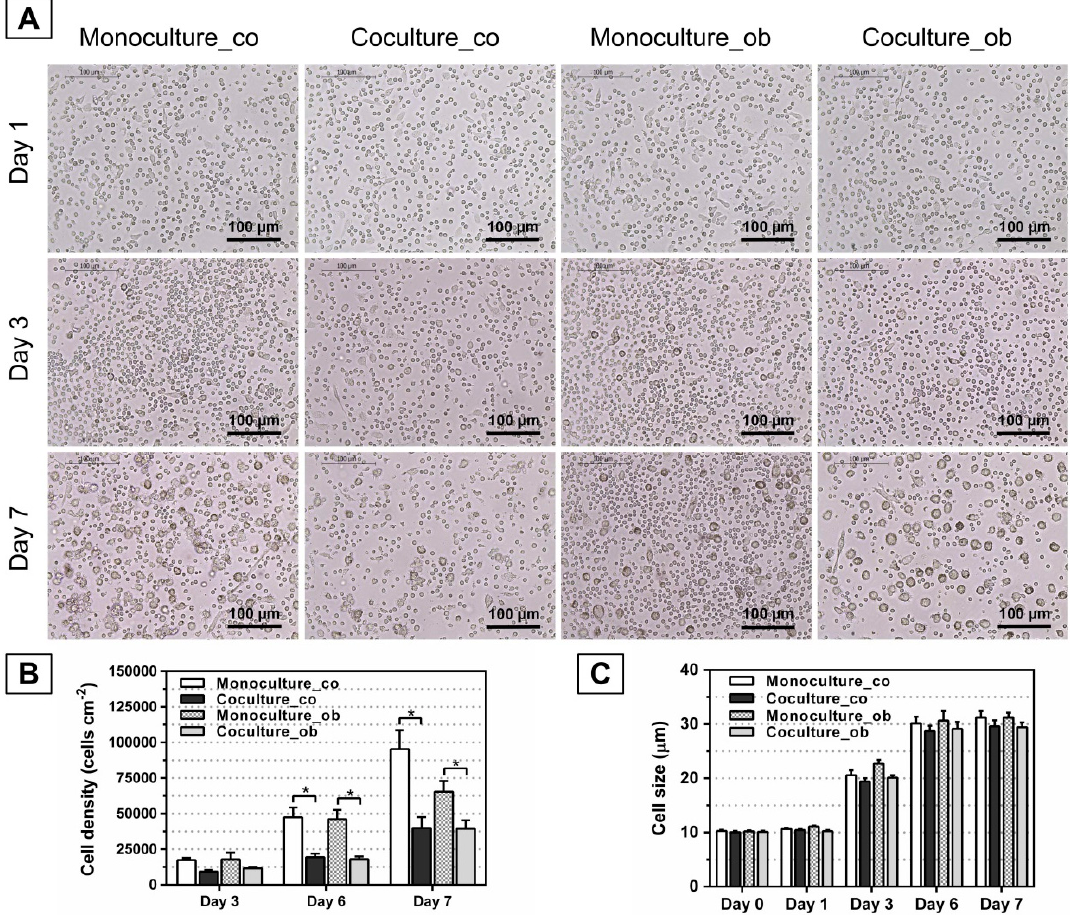
Figure 5. Morphology, cell numbers, and sizes of PBMCs during DC differentiation in monocultures or co-cultures with untreated (co) and osteogenically differentiated JPCs for 21 days (ob). Microscopic images of PBMCs during DC differentiation on day 1, day 3, and 7 are shown ( part A ); Resulting cell numbers (cells/cm 2 , part B ) and determination of cell sizes ( μ m, part C ) in mono- and co-cultures were quantified using the ImageJ software. Results were averaged from 6 independent experiments. Scale bar, 100 μ m.